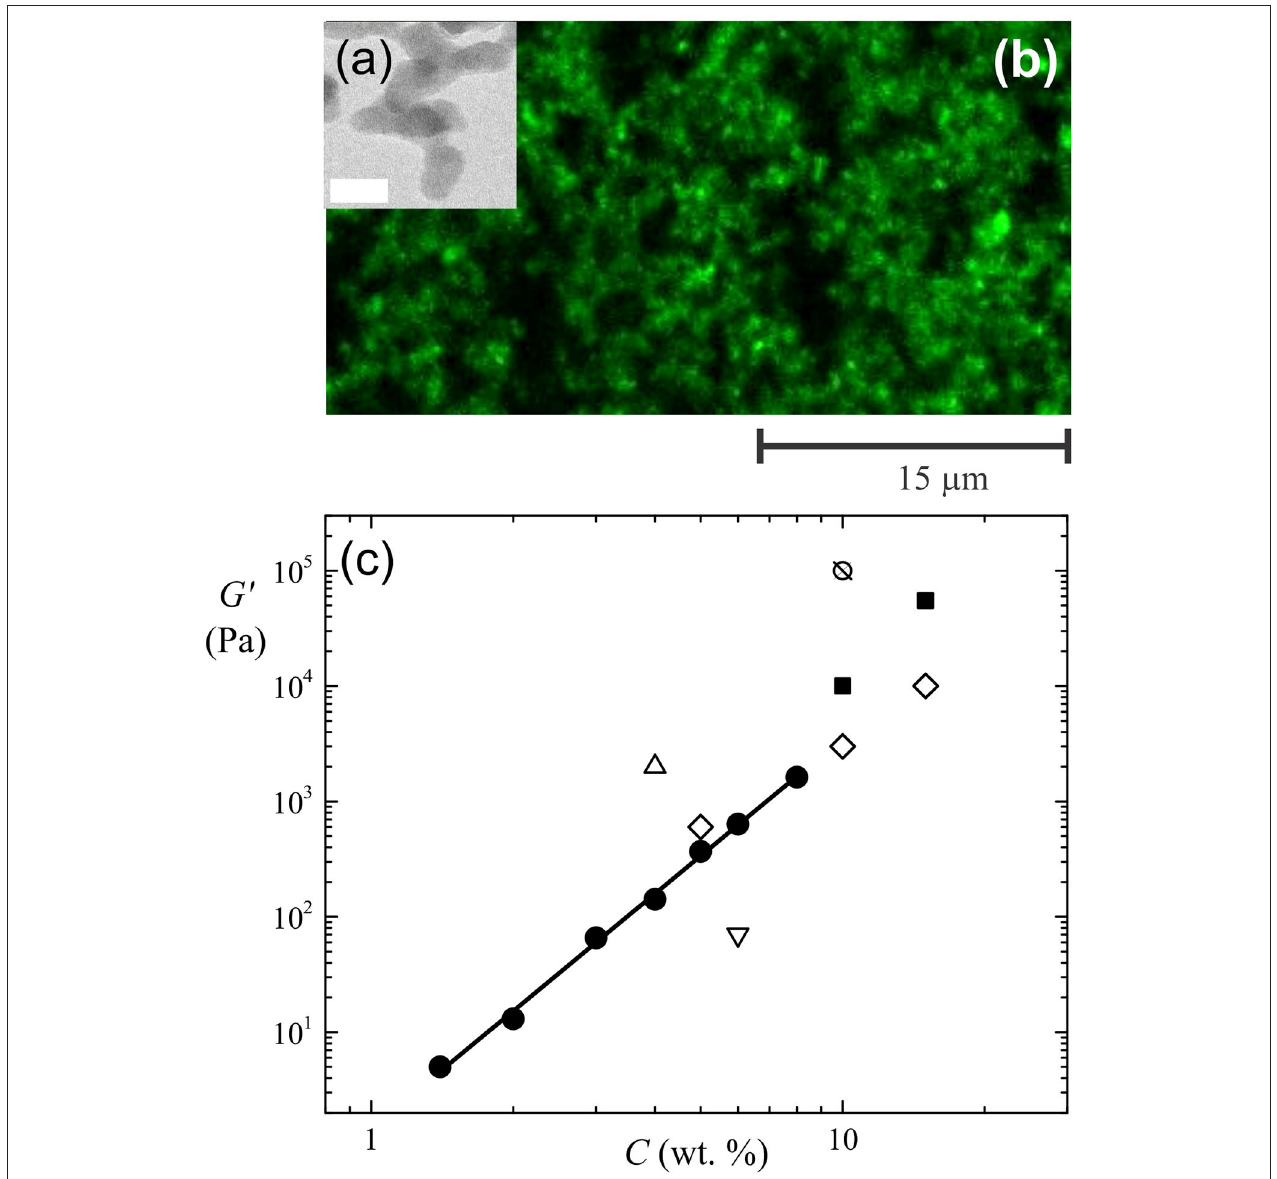
FIGURE 1 | (a) Electron microscope image of primary particles fused together into a chain-like cluster of fumed silica. The white bar corresponds to 20nm. (b) Confocal fluorescence image of the entangled aggregates in a gel of 5 wt. % fumed silica particles in olive oil. (c) Particle concentration ( C ) dependence of the elasticity ( G’ ) of gels of fumed silica in olive oil ( • ) (Whitby et al., 2018) and sunflower oil ( (cid:4) ) (Patel et al., 2015b). The line is a power-law fit of the data for the olive oil gels with a scaling exponent, n = 3.5. For comparison, the elasticity of gels of glyceryl monostearate in a medium chain triglyceride oil ( ♦ ) (Cerqueira et al., 2017), ethyl cellulose in soybean oil ( ⊗ ) (Zetzl et al., 2014), berry wax in sunflower oil ( ∇ ) (Patel et al., 2015a) and carnauba wax in sunflower oil ( 1 ) (Patel et al., 2015a) is also